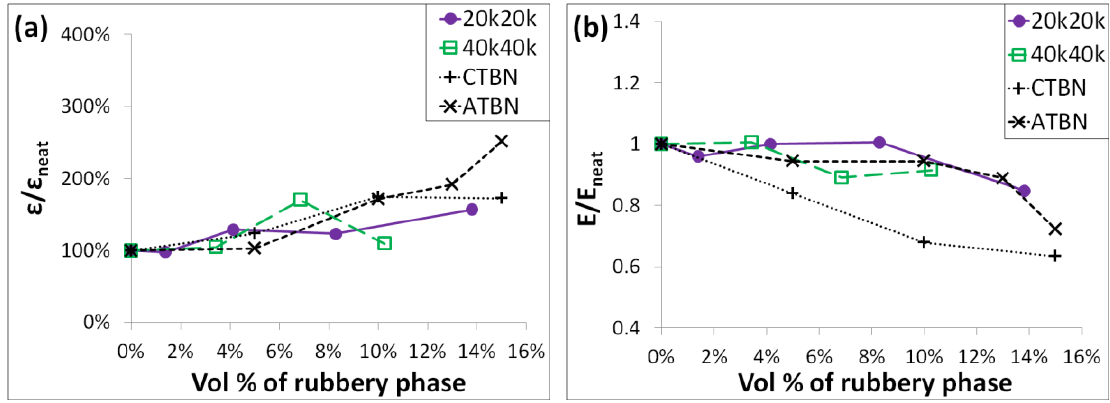
Figure 11. ( a ) Comparison of the improvement in the strain-to-break vs. the volumetric loading of the rubbery phase between the rubbery copolymer grafted SiO /epoxy 2 nanocomposites and conventional rubber (CTBN and ATBN) filled epoxy composites; ( b ) Comparison of the Young‘s modulus vs. the volumetric loading of the rubbery phase between the rubbery copolymer grafted SiO /epoxy nanocomposites and conventional 2 rubber (CTBN and ATBN) filled epoxy composites [29].